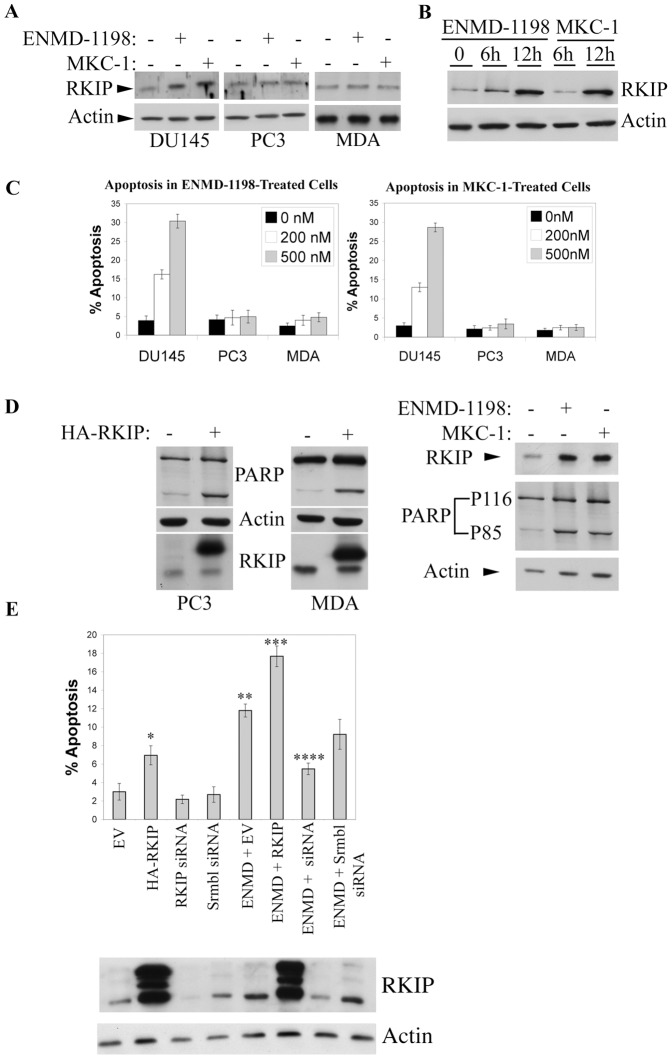
Microtubule inhibitors cause cell cycle arrest and induce RKIP expression.(A) DU145 and PC3 cells were treated with ENMD-1198 or MKC-1. Cells were harvested and washed twice with PBS and whole cell lysates were prepared for Western blot analysis as we have previously reported [28]. Proteins (unless indicated 50 μg/sample was used for Western blot analysis) were separated by 10% SDS-PAGE, transferred to nitrocellulose and analyzed with antibodies to the indicated proteins. Note: for all Western blots described in this Figure legend and for all other subsequent Figure legends, the exposure time used to identify the various proteins was variable. (B) DU145 cells were treated with 200 nM ENMD-1198 or MKC-1 for 6 or 12 h. Cells were prepared for Western blot analysis for the indicated proteins. (C) DU145, PC3 prostate and MDA breast cancer cells (1 × 105) were used for FACS analysis after treatment with the indicated concentrations of ENMD-1198 or MKC-1. Cells were harvested, washed twice with phosphate buffered saline (PBS) and prepared for flow cytometry as previously described (43). Analysis for apoptosis was performed using a FACSCalibur flow cytometer (Data represents the mean ± S.D., of 2 independent experiments performed in duplicate). (D) (Left panel) PC3 and MDA cells were transiently transfected with HA-RKIP expression plasmid for 48 h. Whole cell lysates were prepared and Western blot analysis was performed as described in A for the indicated proteins. Note for this and all other subsequent experiments described where RKIP was transfected into cells, the lower RKIP band represents endogenous RKIP, while the upper RKIP band represents ectopic RKIP (HA-RKIP). (Right panel), DU145 cells were treated with ENMD-1198 or MKC-1 for 24 h. Whole cell lysates were prepared and Western blot analysis was performed for the indicated proteins. (E, top) DU145 cells were transiently transfected with various combinations with expression plasmids for RKIP, RKIP siRNA, scramble siRNA or empty vector (EV) for 48 h. The cells were treated with 200 nM ENMD-1198 for 24 h. Cells were harvested and analyzed for apoptosis as described in (C). A paired t-test was performed to analyze the increase in apoptosis in cells when compared to empty vector (EV): *(p<0.001) transiently transfected with RKIP; **(p<0.00007) treated with ENMD-1198; ***(p<0.0002) with the combination of RKIP transfection and ENMD-1198 treatment. Scrmbl = scrambled siRNA. A decrease in apoptosis was observed ****(p<0.000012) in cells treated with ENMD-1198 when compared to cells transiently transfected with RKIP siRNA and treated with ENMD-1198. (Data represents the mean ± S.D., of 2 independent experiments performed in triplicate). (E, bottom) Western blot analysis of the same experimental conditions described in Fig. 2E, top. The Western blot analysis was repeated 3 times and the Figure is representative of one of the experiments. Densitometry was performed and the relative intensity (fold increase) when compared to Actin for lanes 1-8, respectively were 0.78, 1.7, 0.19, 0.84, 0.99, 0.67, 0.36 and 0.92.